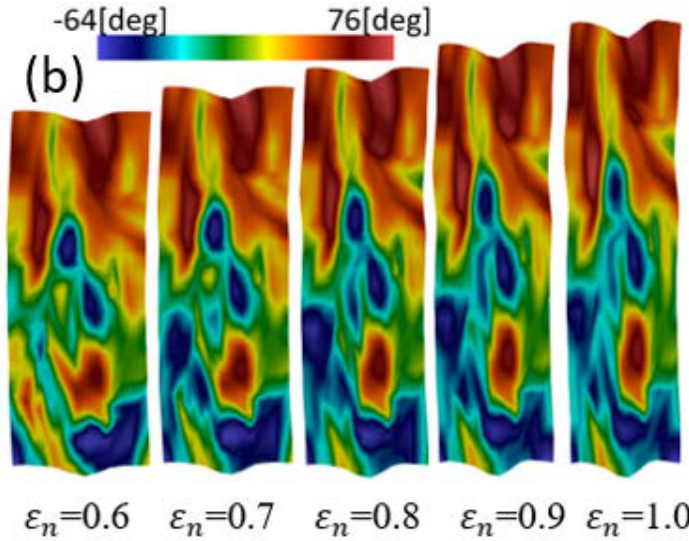
Figure 12. The distribution of the rotation angle of the transformation variant of ( a ) 4-grain and ( b ) 14-grain polycrystal TRIP steel with crystallographic orientations given randomly.